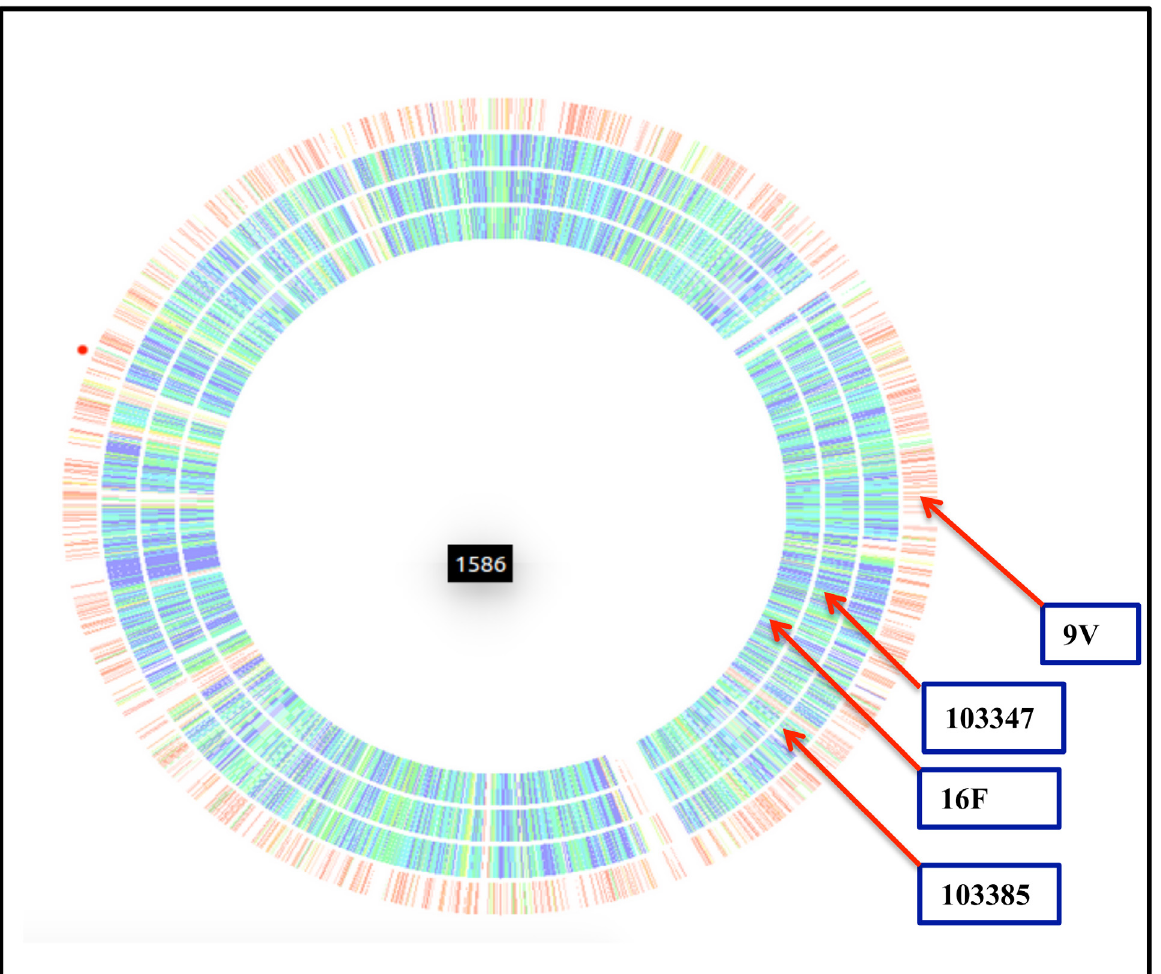
Fig 4. Comparative genome analysis of pneumococcal serotypes 16F and 9V genetic background. When the sequence identities of all four genomes were compared using RAST(Rapid Annotation using Subsystem Technology), the genome backbone of all three 16F (103347 and 103385 from this study and a 16F control strain) were mostly identical but divergent from 9V. The colour codes represent how close or divergent the genomes are. Therefore, similar genome backgrounds will have similar